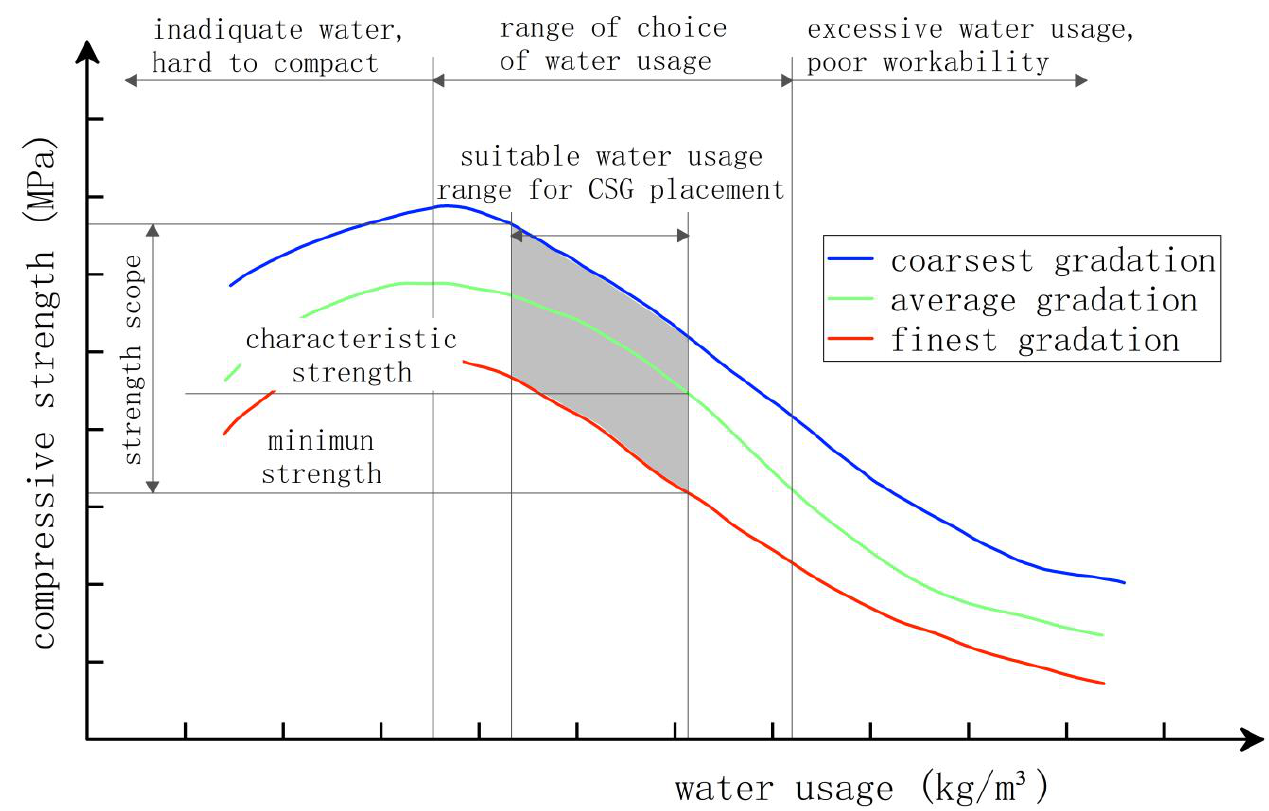
Figure 11. Relationship between the water use and compressive strength of cemented sand and gravel materials.